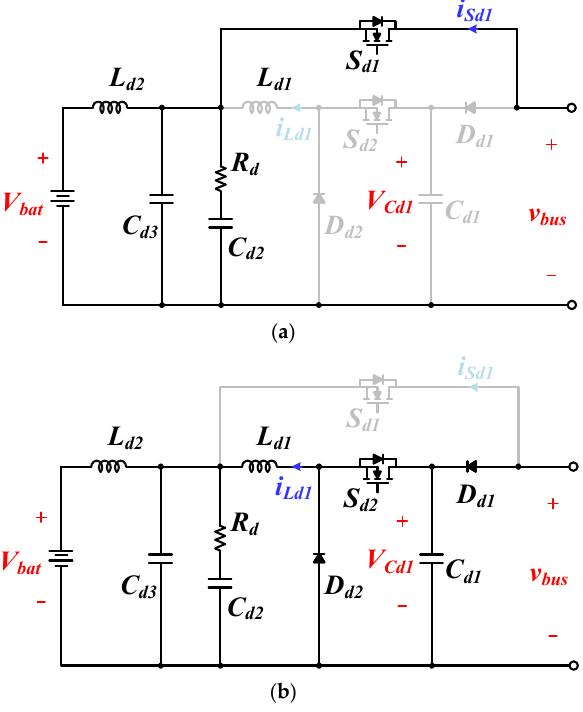
Figure 4. Operation of the proposed DIBC, ( a ) mode DI, ( b ) mode DII.